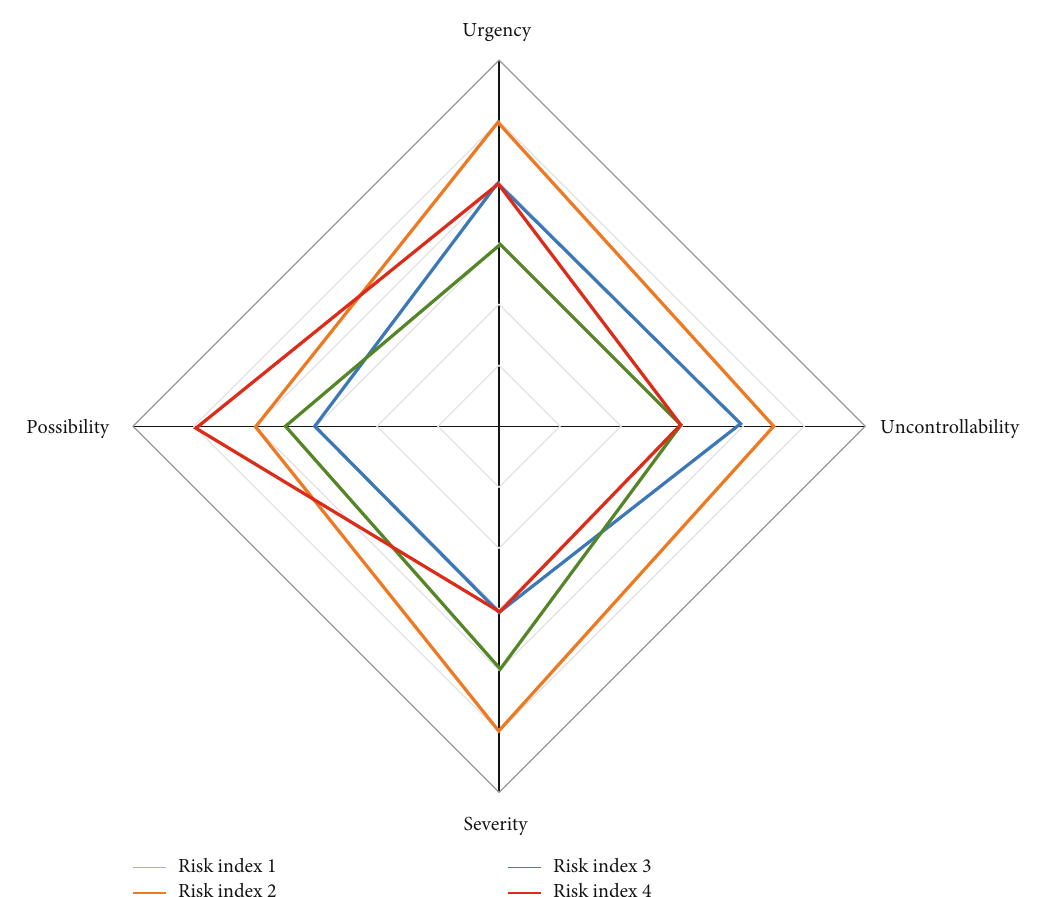
Figure 3: Four-dimensional risk analysis